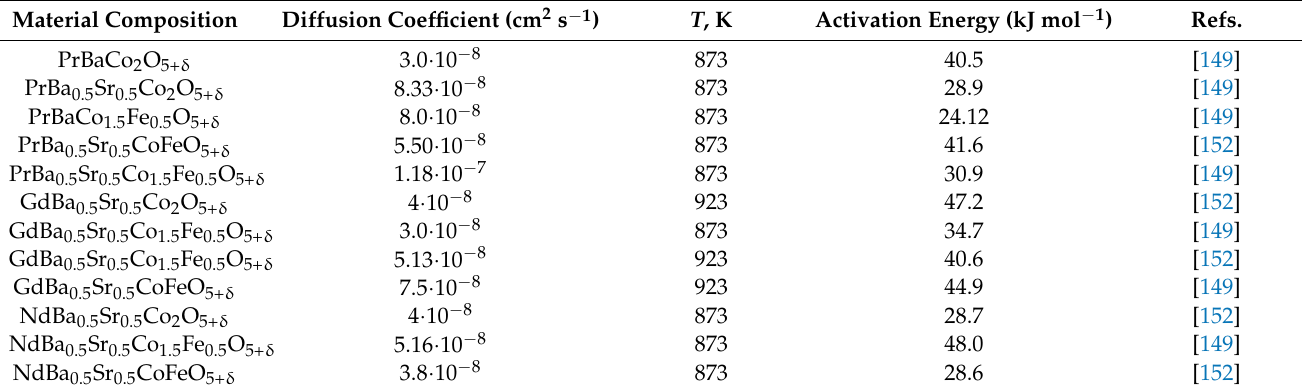
Figure 8. I–V curves and corresponding power densities of test cells with different cathodes ( a , c ) Ba 0.5 Sr 0.5 Co 0.8 Fe 0.2 O 3– δ –Nd 0.1 Ce 0.9 O 2– δ and ( b , d ) NdBa 0.5 Sr 0.5 Co 1.5 Fe 0.5 O 5+ δ –Nd 0.1 Ce 0.9 O 2– δ under various cathode air flow rates ( a , b ) and humidities ( c , d ). The single cells were operated at 923 K with humidified H 2 (3vol.% H 2 O) as the fuel and ambient air as the oxidant. ( a , b ) air flow rate change: 50, 100, 150, and 200 sccm. ( c , d ) air humidity change: dry, 3 vol.%, 5vol.%, and 7vol.% H 2 O (reproduced with permission from [151]. Copyright 2016, Elsevier). Table 6. Oxygen anion diffusion coefficients and activation energies calculated using molecular dynamics for REE–barium layered double cobaltites.